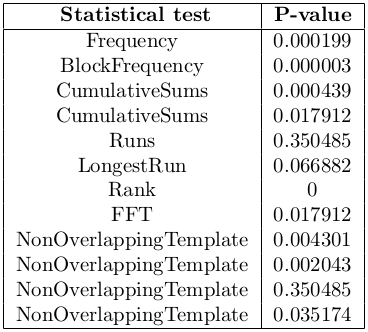
Table from the paper: Hardware Random number Generator for cryptography
Table text:
Statisticaltest
P-value
Frequency
0.000199
BlockFrequency
0.000003
CumulativeSums
0.000439
CumulativeSums
0.017912
Runs
0.350485
LongestRun
0.066882
Rank
0
FFT
0.017912
NonOverlappingTemplate
0.004301
NonOverlappingTemplate
0.002043
NonOverlappingTemplate
0.350485
NonOverlappingTemplate
0.035174